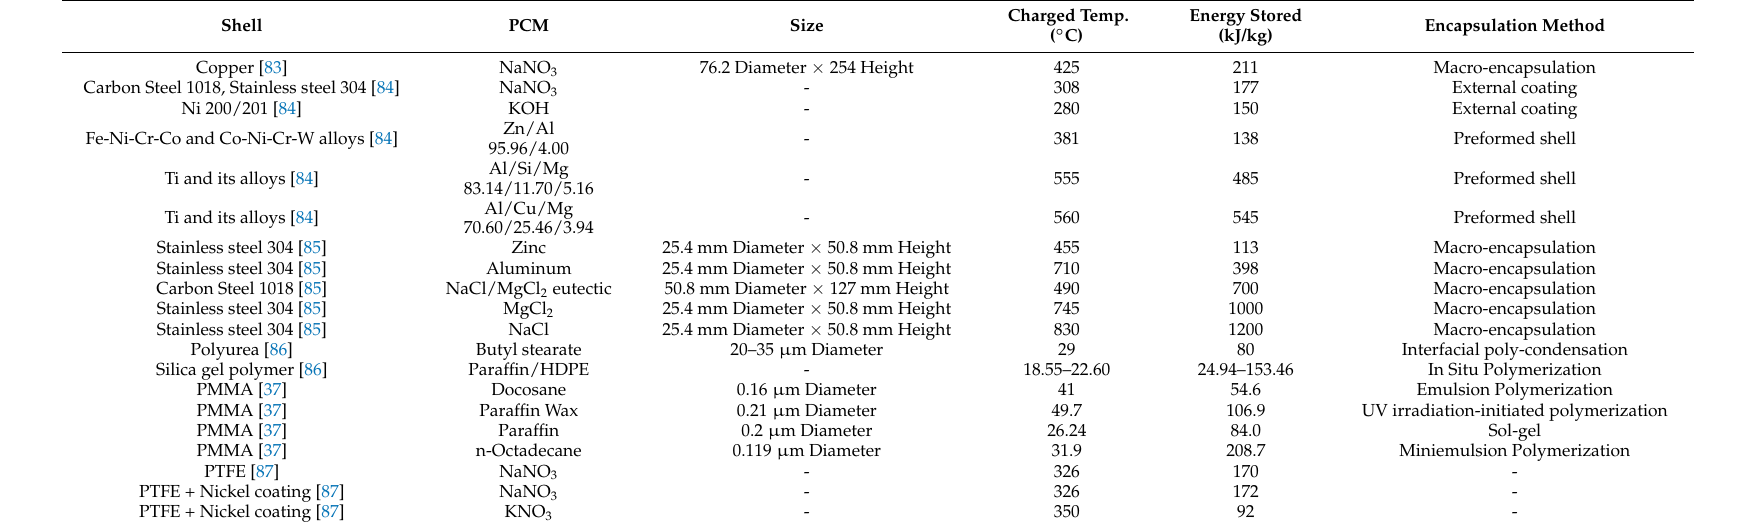
Table 3. Thermal properties of selected